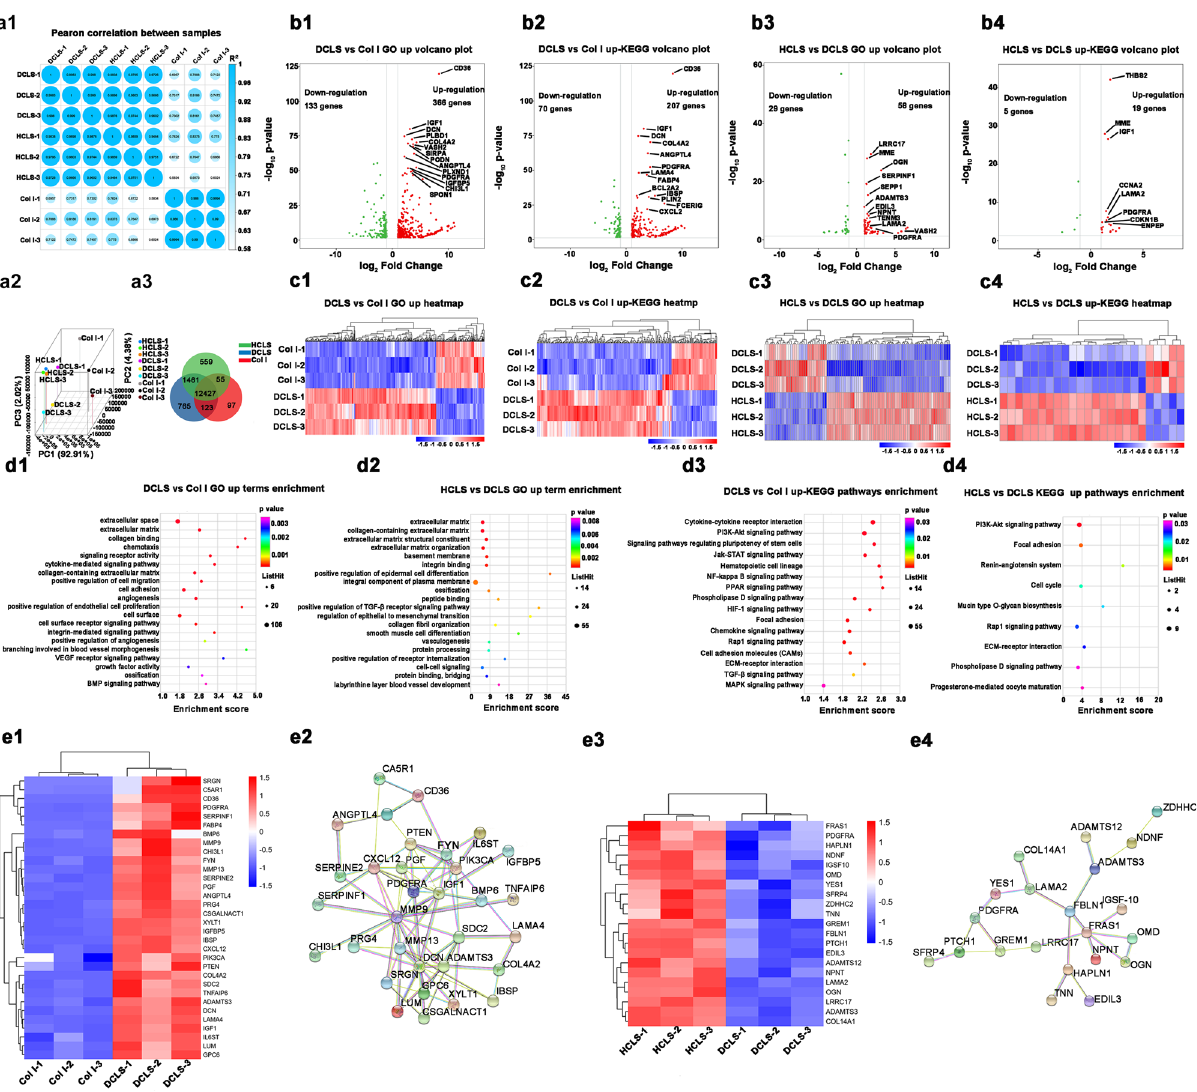
Fig. 6 Self-adhesive and fl exible scaffold regulates gene expressions related to osteogenesis, angiogenesis, and ESCs recruitment in vitro. a1 Heatmap of Pearson correlation between samples. a2 3D image of principal component analysis of different samples. a3 Venn diagram of the number of differentially expressed genes in different samples. b1 – 4 Volcano plot of transcriptomic analysis of differentially expressed genes. n = 3 independent experiments per group. c1 , c3 Heatmap analysis of differentially expressed genes involved in top enriched up-Gene Ontology (GO) database. c2 , c4 Heatmap analysis of differentially expressed genes involved in top enriched up- Kyoto Encyclopedia of Genes and Genomes (KEGG) pathways. d1 , d2 Enriched GO up terms of DCLS versus Col I and HCLS versus DCLS. d3 , d4 Enriched KEGG pathways of DCLS versus Col I and HCLS versus DCLS. e1 , e3 Heatmap of differentially expressed genes involved in cellular activity, osteogenesis, angiogenesis, and ESCs recruitment of DCLS versus Col I and HCLS versus DCLS. e2 , e4 String interaction network of differentially expressed genes involved in cellular activity, osteogenesis, angiogenesis, and ESCs recruitment of DCLS versus Col I and HCLS versus DCLS. (Two-sided comparison, Error bars represent standard deviation, * p < 0.05, n = 3 biologically independent